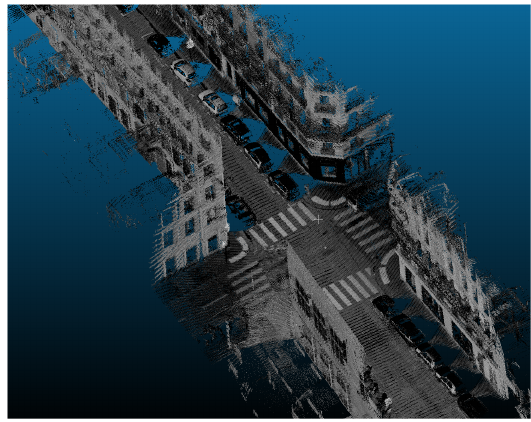
Figure 2: Example of a point cloud and its expected optimal (minimum) value is related to the global covariance of the point cloud